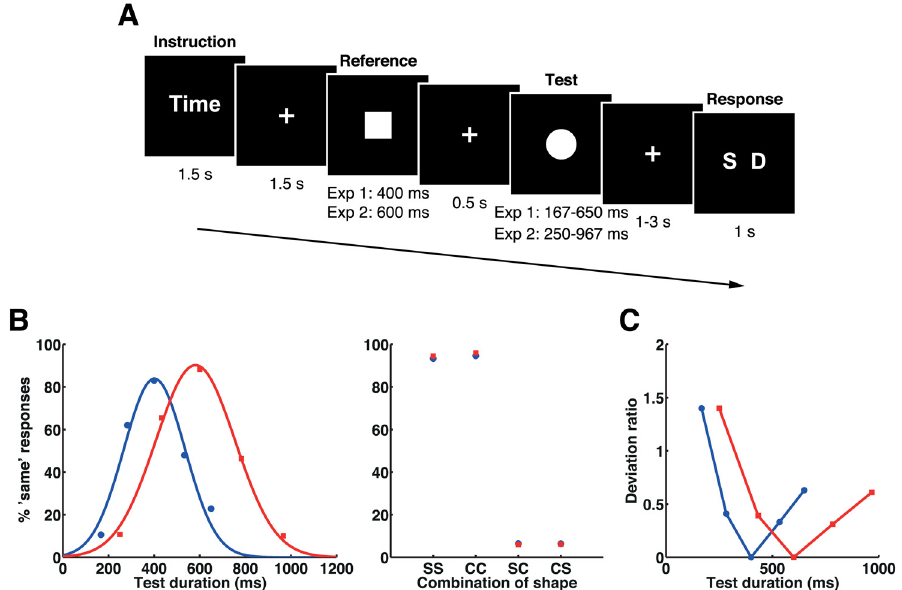
Fig 1. Stimulus sequence, mean task performances, and deviation ratios in experiments 1 and 2. (A) The stimulus sequence. Participants were asked to respond with whether the durations of two sequentially presented visual stimuli were the same or different in the time task and whether the shapes of the two stimuli were the same or different in the shape task. (B) Mean task performances in experiments 1 (blue) and 2 (red). Proportions of the “ same ” responses for the time task were fitted by Gaussian functions for presentation purpose (left). The proportion of the “ same ” response for the shape task is shown for each combination of reference and test shapes (right). Letters on the x -axes represent combinations of shapes for reference and test stimuli: square-square (SS), circle-circle (CC), square-circle (SC), and circle-square (CS). Please refer to S1 Data for the numerical values underlying these figures. (C) Plots of deviation ratios for each set of stimulus durations in experiments 1 (blue) and 2 (red).